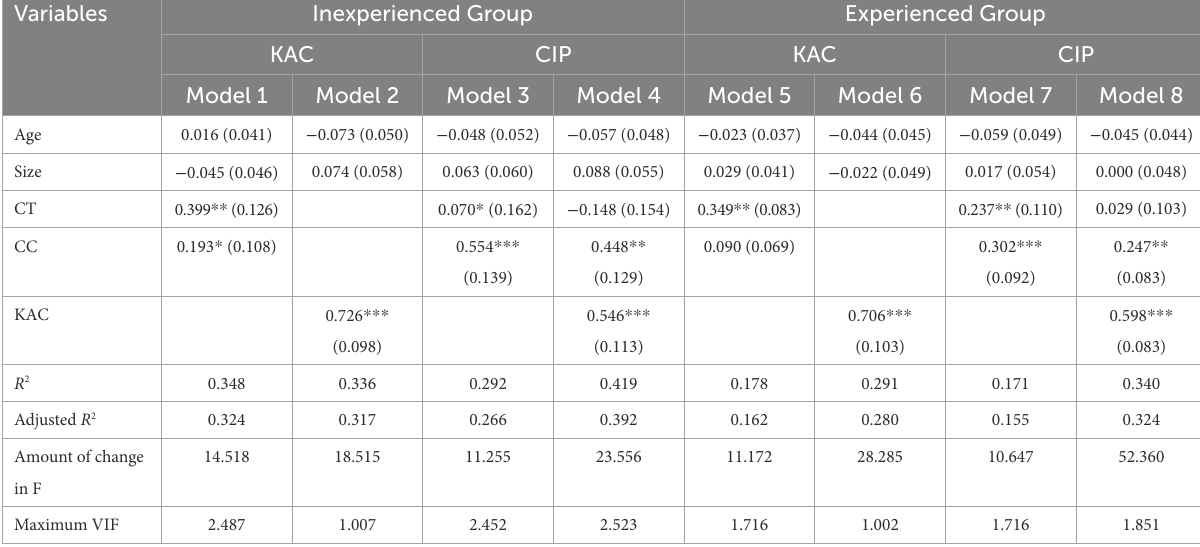
TABLE 8 Heterogeneity analysis of enterprise cooperation